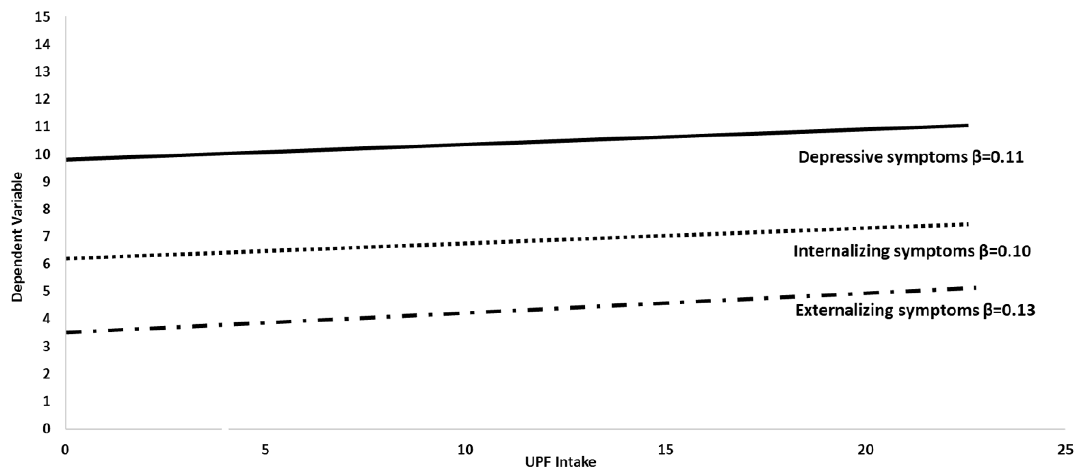
Figure 3. Association between the total consumption of ultra-processed foods and drinks and depressive symptoms, internalizing and externalizing problems in all participants, adjusting for age, sex, fruits and vegetables consumption, and physical activity (Model 2). ß are standardized coefficients adjusted for sex, age, physical activity, and fruits and vegetables intake as in Model 2.